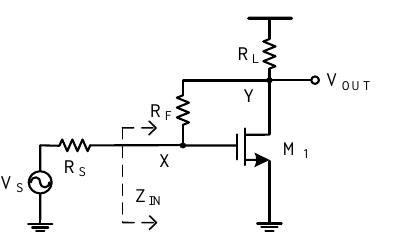
Figure 4. Resistive shunt-feedback amplifier with high bandwidth and wideband impedance match- ing. [ 13 ]